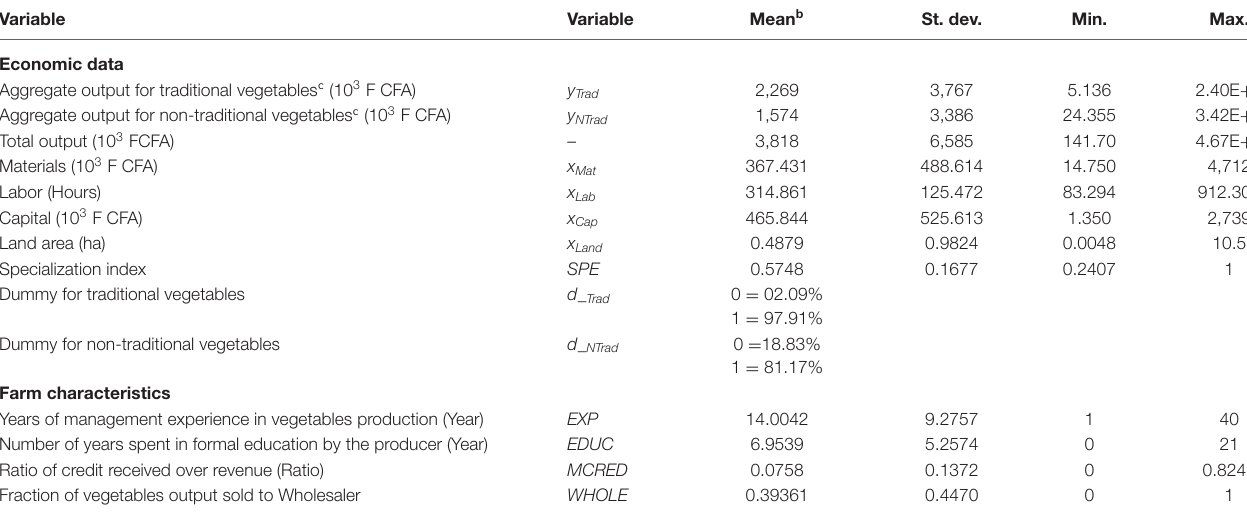
TABLE 1 | Descriptive statistics of the variables a ( n =